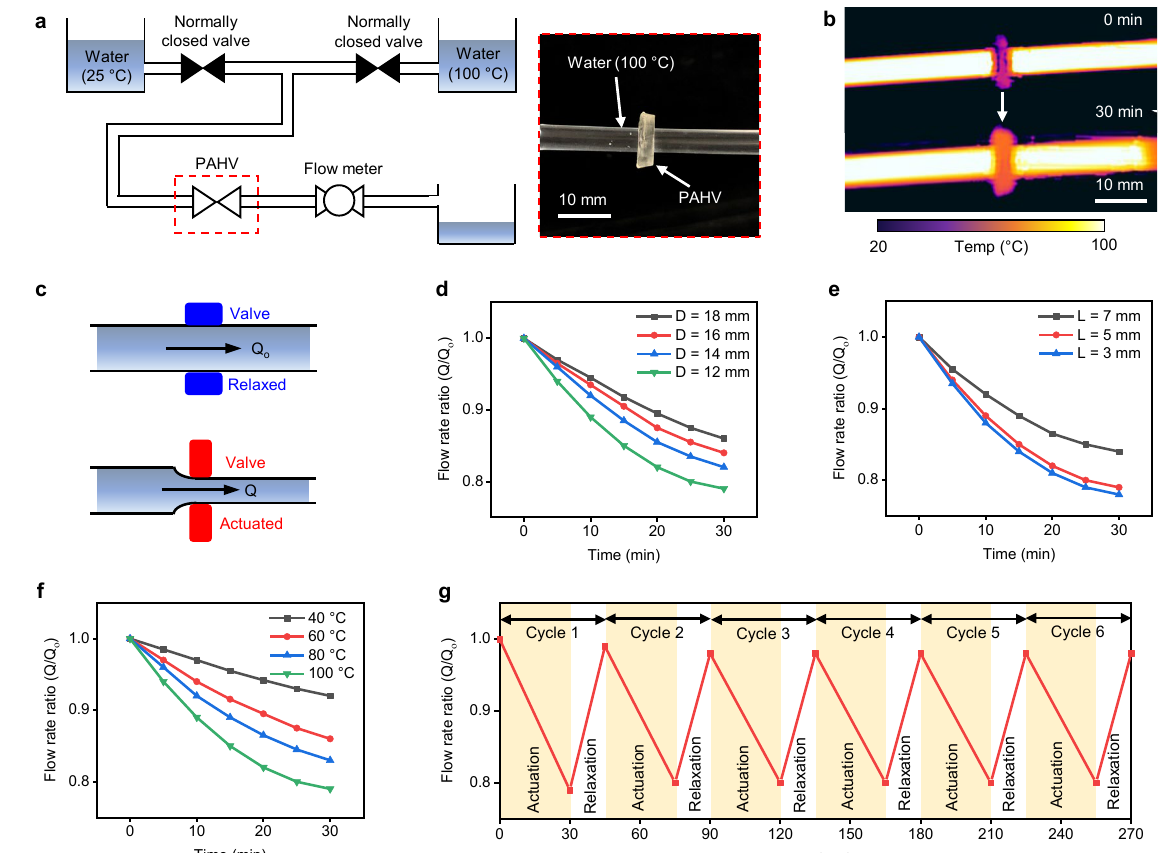
Figure 10. PAHV performance for flow control application. ( a ) Real-time photograph showing the PAHV’s flow control system setup. ( b ) IR images showing the actuation of the PAHV flow control valve when the fluid is at 100 ◦ C. ( c ) Schematic demonstrating the PAHV’s flow control valve mechanism. ( d ) PAHV flow rate ( L = 5 mm) for different diameters (12–18 mm) when fluid is at 100 ◦ C. ( e ) PAHV flow rate ( D = 12 mm) for different lengths (3–7 mm) when fluid is at 100 ◦ C. ( f ) PAHV flow rate ( D = 12 mm, L = 5 mm) when fluid is at different temperatures (40–100 ◦ C). ( g ) Flow rate in PAHV ( D = 12 mm, L = 5 mm) for 6 cycles when actuating fluid is at 100 ◦